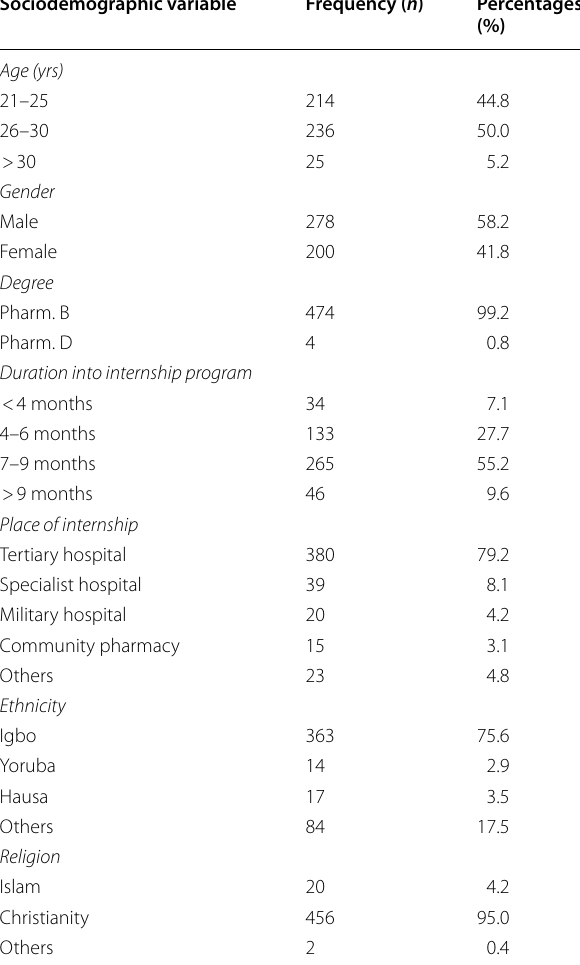
Table 1 Summary of the sociodemographic characteristics of study population ( n =